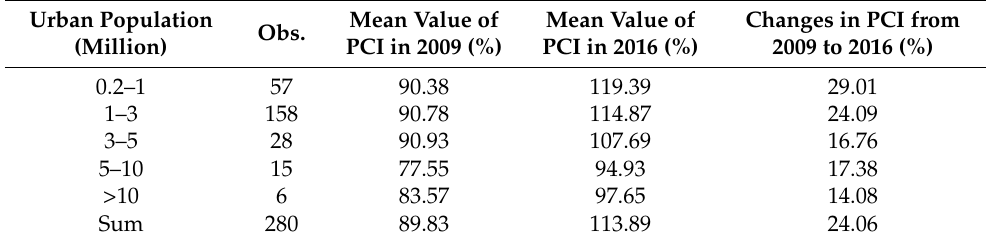
Table 4. Statistics of PCI values in cities with different urban population. Urban Population (Million)